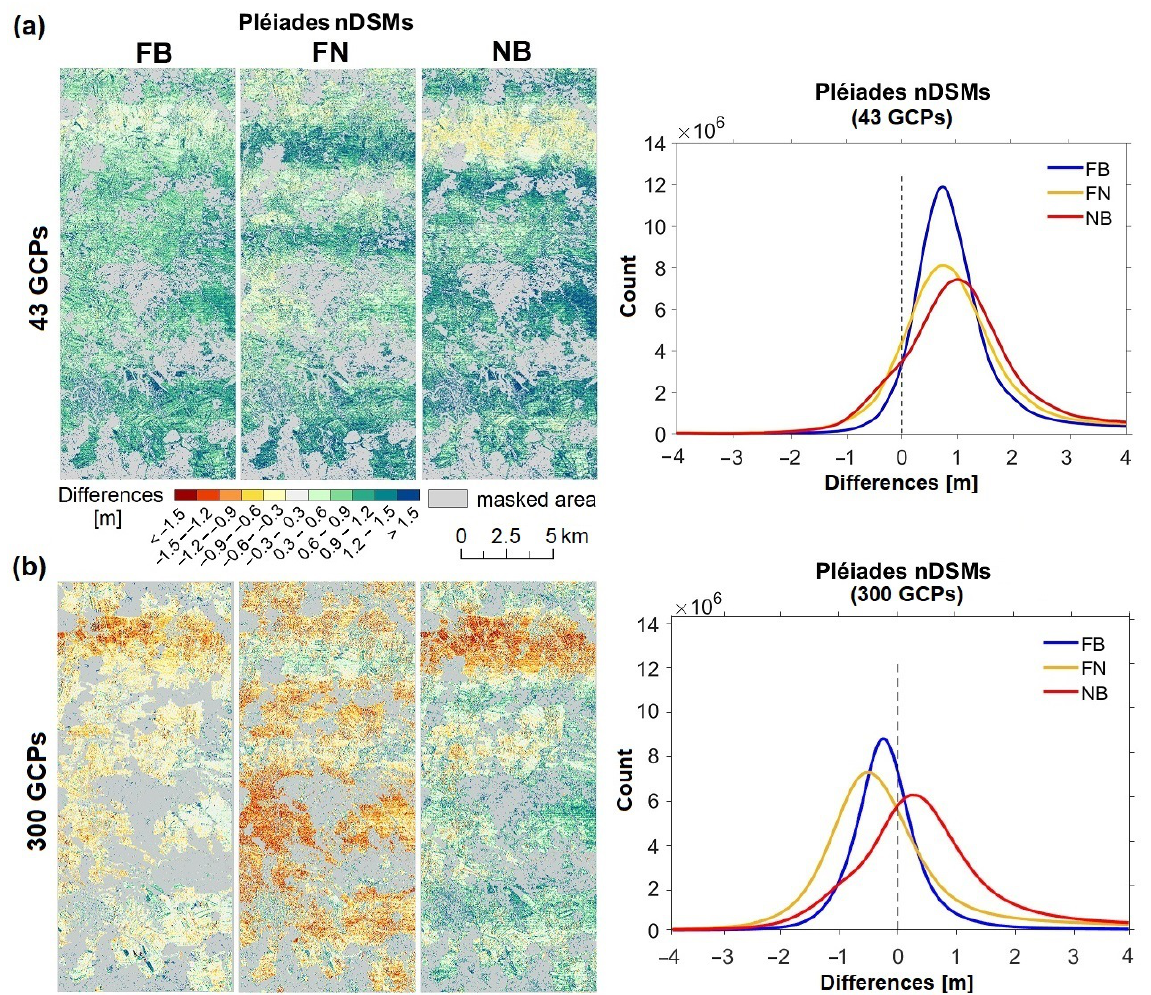
Figure 12. Pléiades nDSMs for open areas with corresponding frequency distribution of height discrepancies: ( a ) Image georeferencing with bias-corrected RPCs using 43 GCPs. ( b ) Image georefer- encing with bias-corrected RPCs using 300 GCPs. Table 4. Accuracy assessment of Pléiades DSMs in open areas (given values are in meters). Scene